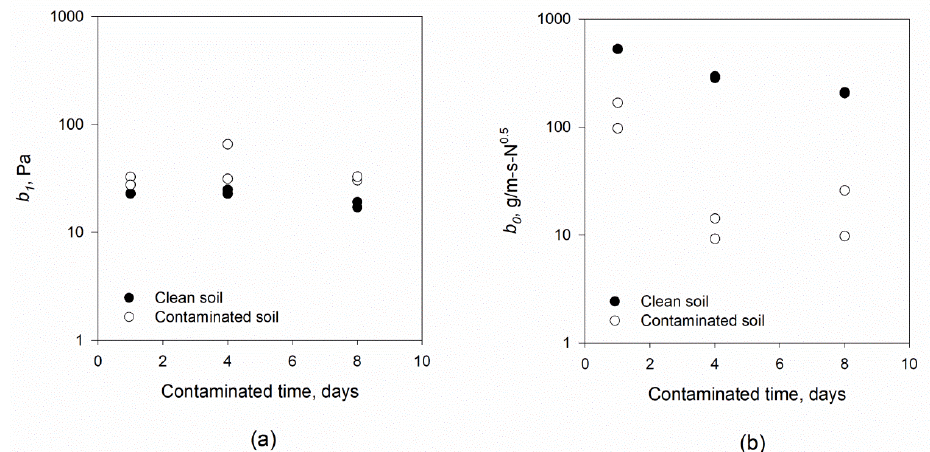
Figure 7. Comparison between clean soil and crude oil contaminated soil at different contaminated times (1st, 4th, and 8th) days of deriving Wilson model parameters of small scale setup at dry soil moisture content: ( a ) parameter b 1 and ( b ) parameter b 0 . Table 5. Crude oil parameters ( f co and µ or ) and the results of the Normality Test (Shapiro-Wilk) between clean and crude oil contaminated soils for the given Wilson model parameters after 1, 4, and 8 days of